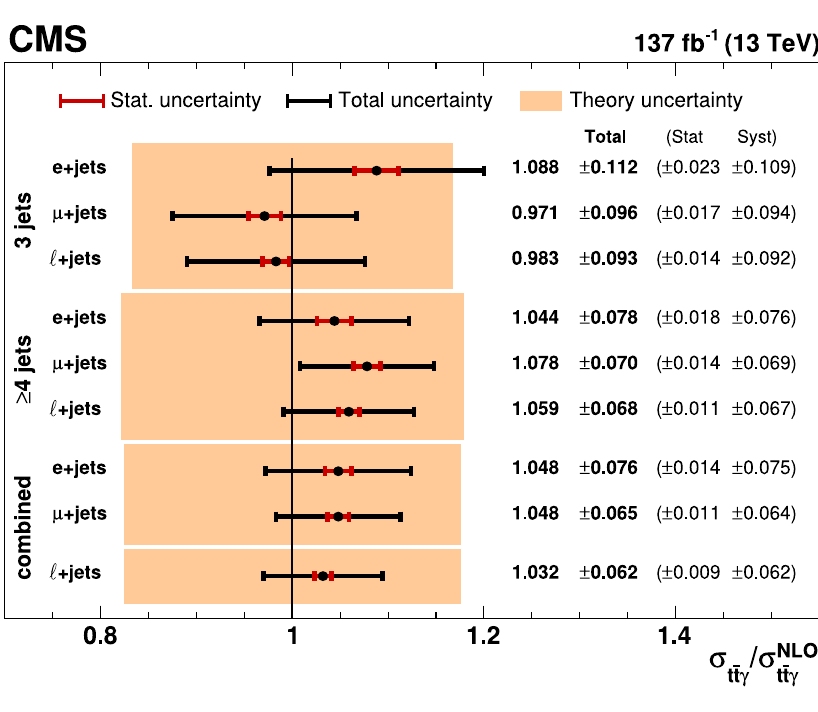
Figure 8 . Summary of the measured cross section ratios with respect to the NLO cross section prediction for N = 3 , ≥ 4, and combined signal regions in the electron channel, muon channel, j and the combined single-lepton channel. The orange band indicates the theory uncertainty in the prediction.